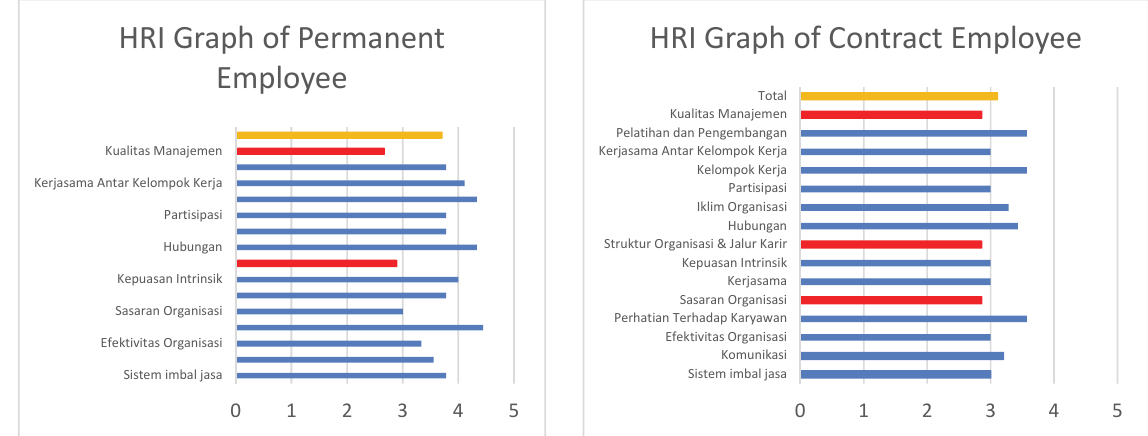
Fig. 3. HRI Graph both of Permanent and Contract